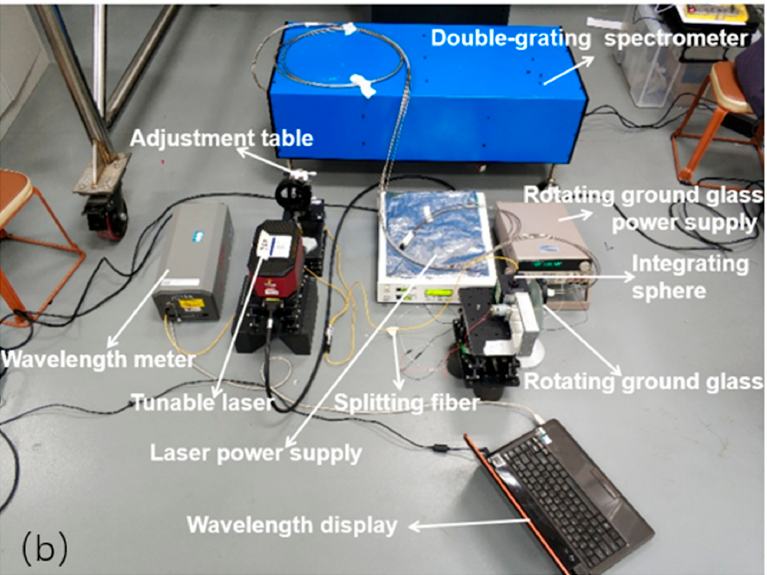
Figure 15. Molecular oxygen A-band (758–778 nm) spectrum calibration system ( a ) Molecular oxygen A-band (758–778 nm) spectrum calibration flow chart; ( b ) The instrument of the Molecular oxygen A-band (758–778 nm) spectrum calibration system and the working principle. Under the spectral calibration demand of the water vapor band channels, the tunable laser cannot output such a wide-band (758–880 nm) radiation, so a spectrum calibration scheme combining a continuous spectrum laser and a monochromator was adopted for water vapor band channels. The schematic diagram and the physical composition of the calibration system are shown in Figure 16. During the calibration, the tunable laser (when calibrating the molecular oxygen A-band) and the monochromator (when calibrating the water vapor absorption band) were adjusted to scan the wavelength at a certain interval. Meanwhile, the response of DGSS was recorded, that is, the instrument is in the gray value response under different monochromatic light irradiation. After the response value is processed by pixel merging, the power correction, the normalization and normal fitting, and the normalized spectral response function of each PBSC can be obtained.